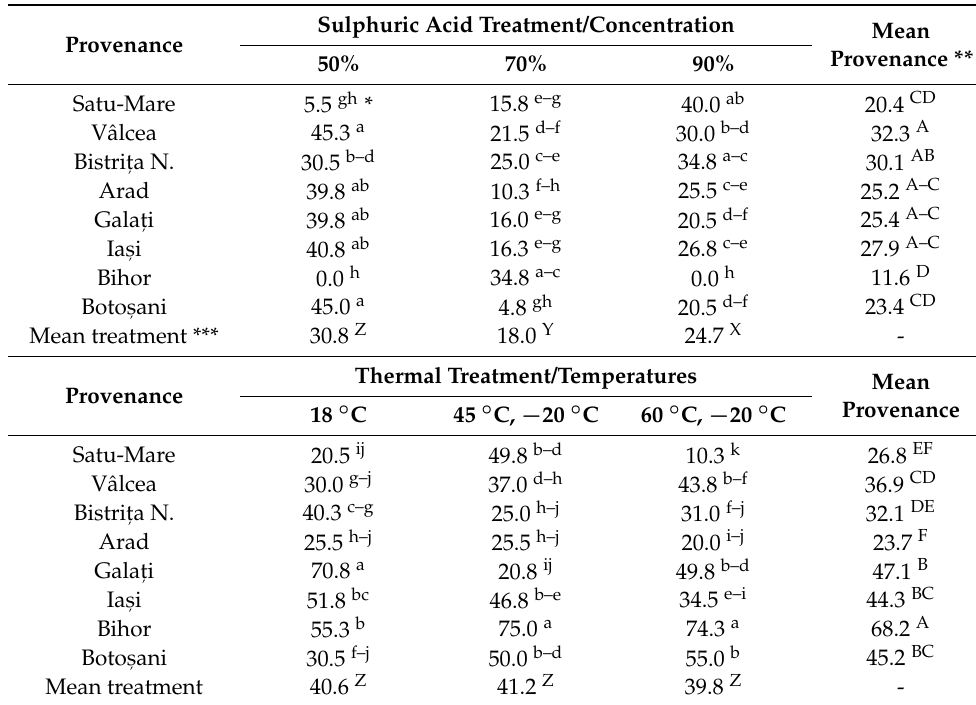
Table 3. Black locust seed germination (%) depending on the treatments